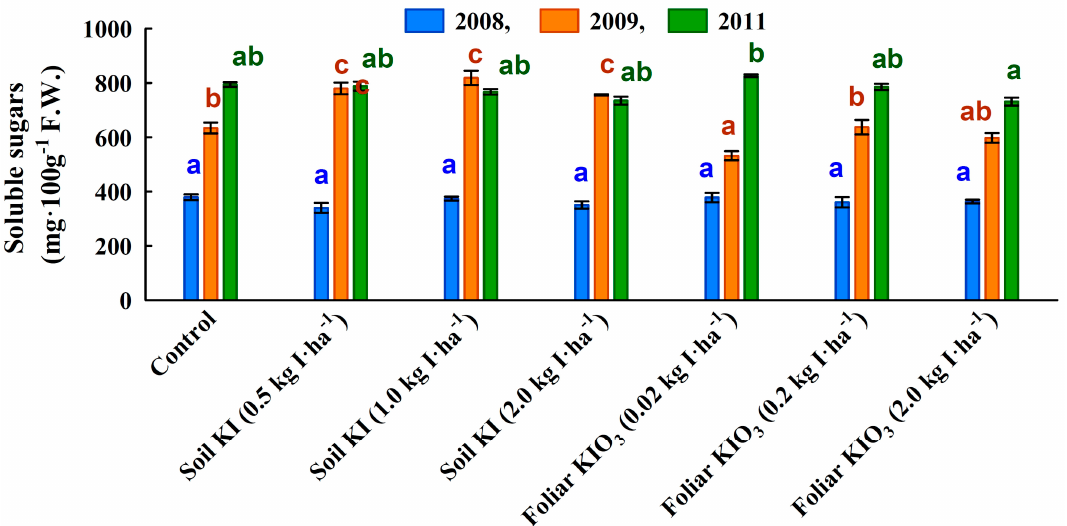
Figure 5. Content of soluble sugars in potato tubers in individual years the study; values followed by the same letters within an individual year are not statistically different at p < 0.05, ( n = 4).